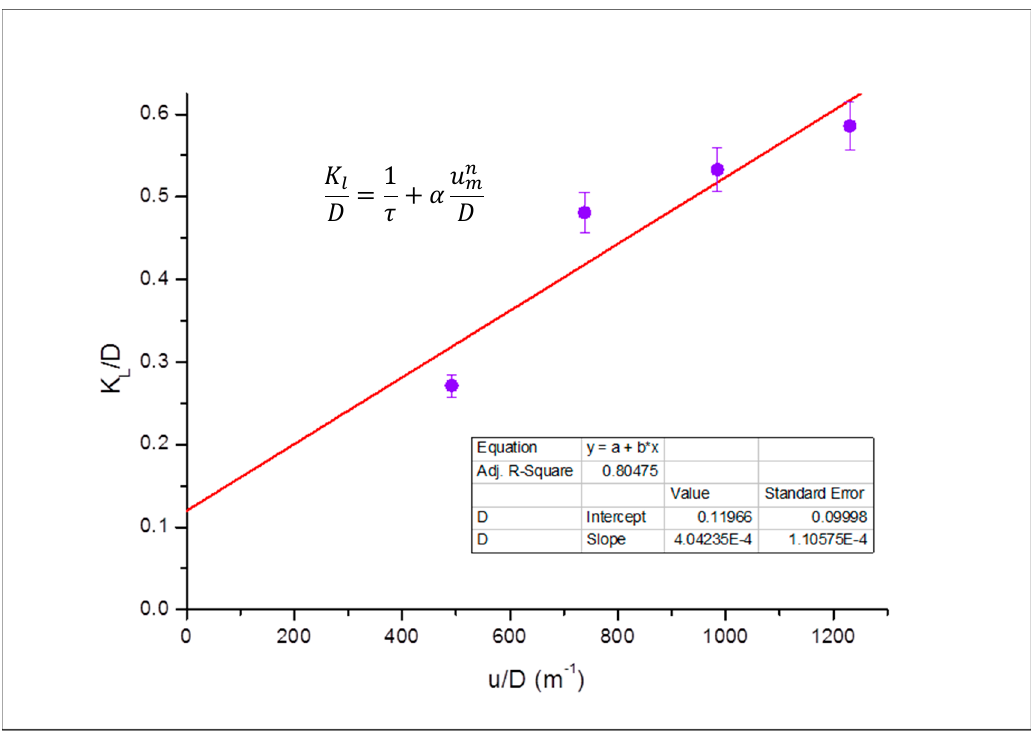
Figure 13. Dispersivity evaluation for Buff Berea in the vertical orientation.